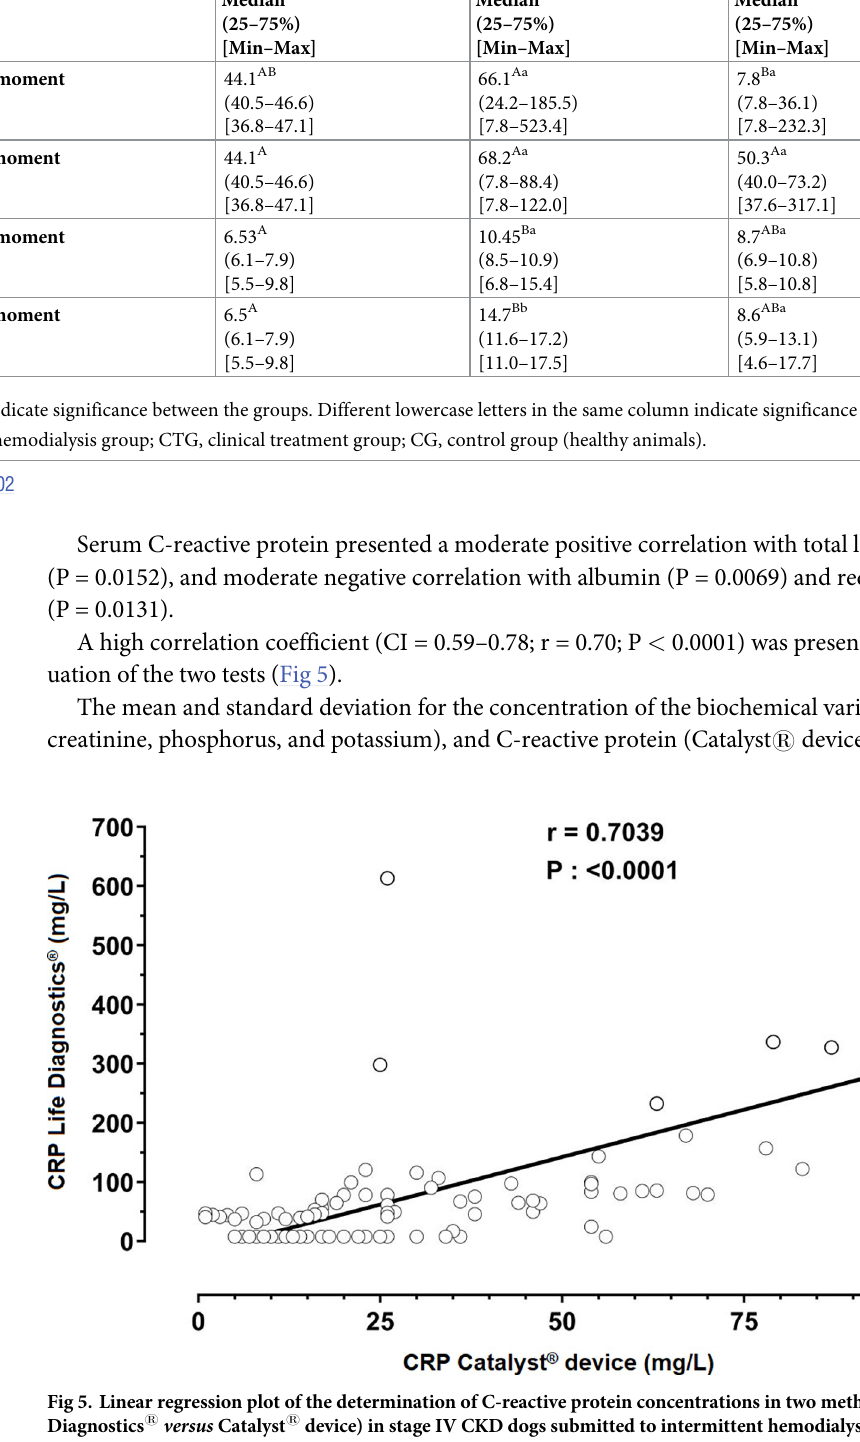
Table 2. Median, interquartile interval (25–75%), minimum (min) and maximum values (max) for C-reactive protein (Life Diagnostics 1 ), and total leukocytes at the first- and last-moments in dogs from CG, IHG and CTG. Variables